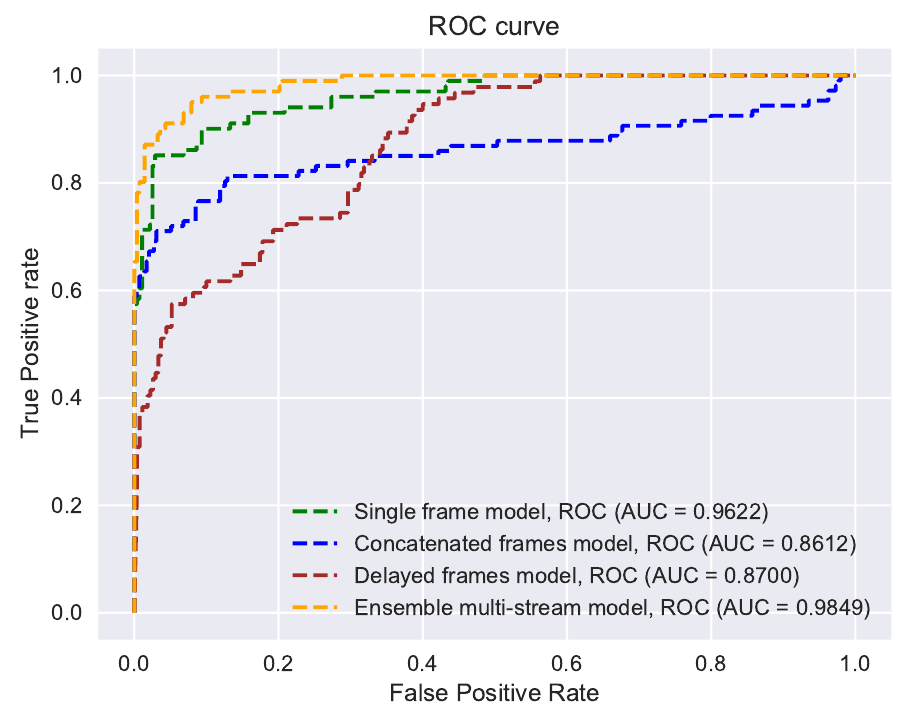
Figure 9. Receiver operating characteristics (ROC) of the methods evaluated on our testing database. Compared to other models; the ensemble multi-stream model produced better classification